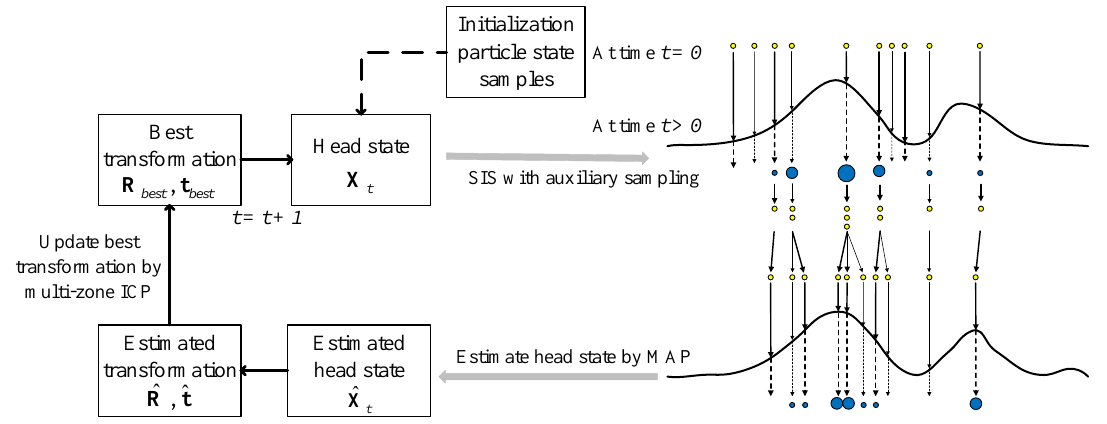
Figure 6. Head state tracking by particle